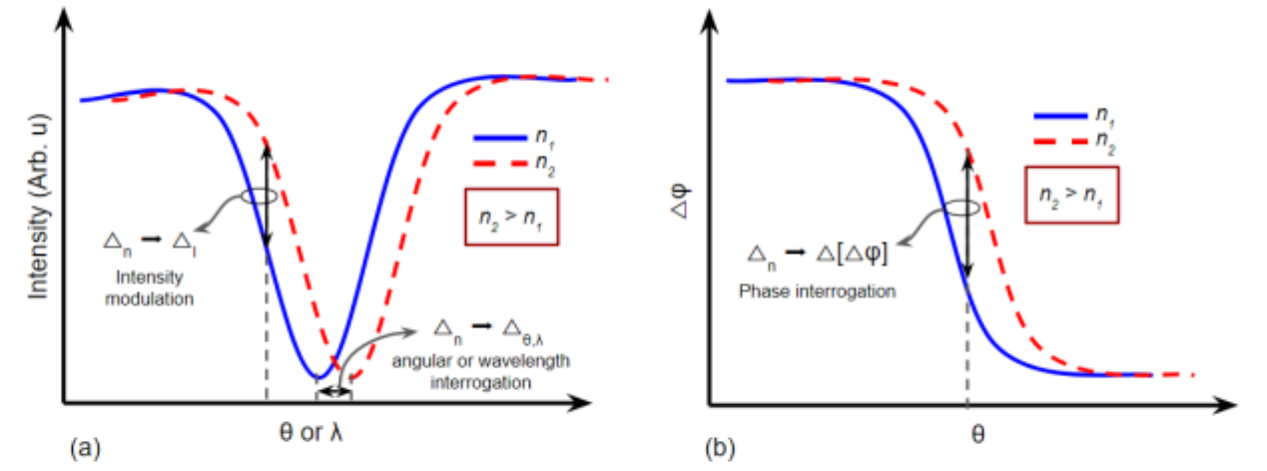
Figure 10. The methodology of SPR measurement ( a ) principle of intensity, angular, and wavelength interrogations. ( b ) The principle of phase interrogation method for SPR signal acquisition. Figure adapted from [62].